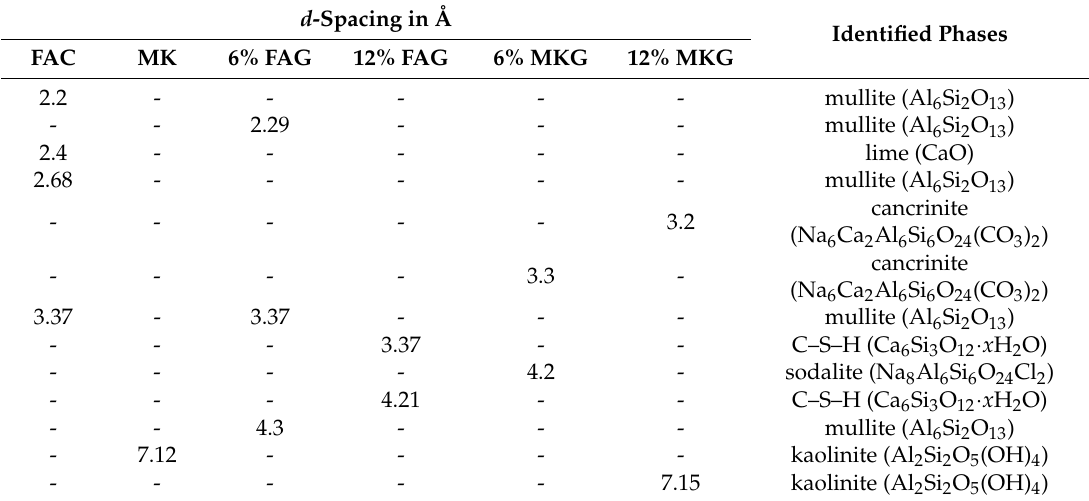
Table 4. Reported phase reflexes from aluminosilicate sources (FAC and MK) and treated soils.